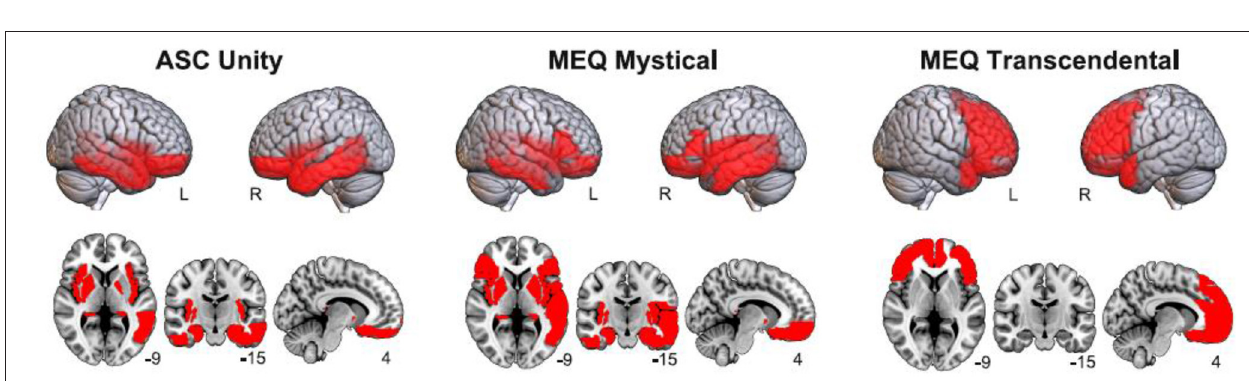
FIGURE 2 | Matrix with all correlations between questionnaire subscales (y-axis) and source theta power computed for all AAL regions (x-axis). Significant correlations were in all cases negative and are indicated by colored entries.